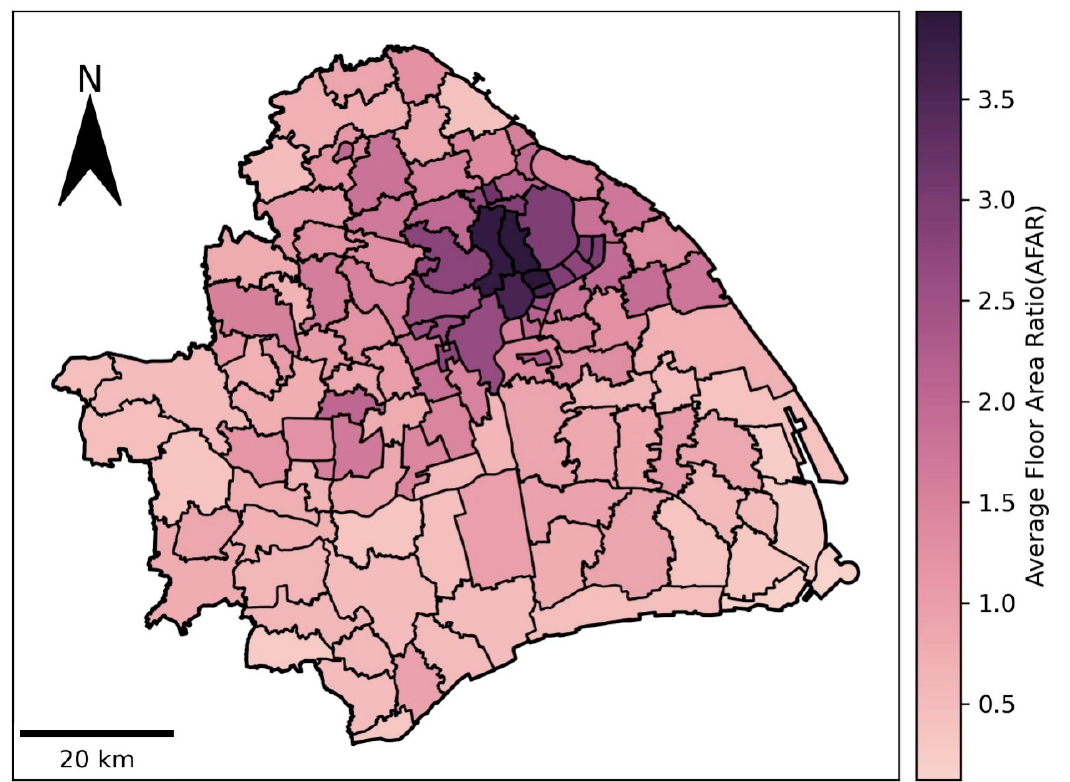
Figure 2. Calculation results for the average floor area ratio in the sample study area.